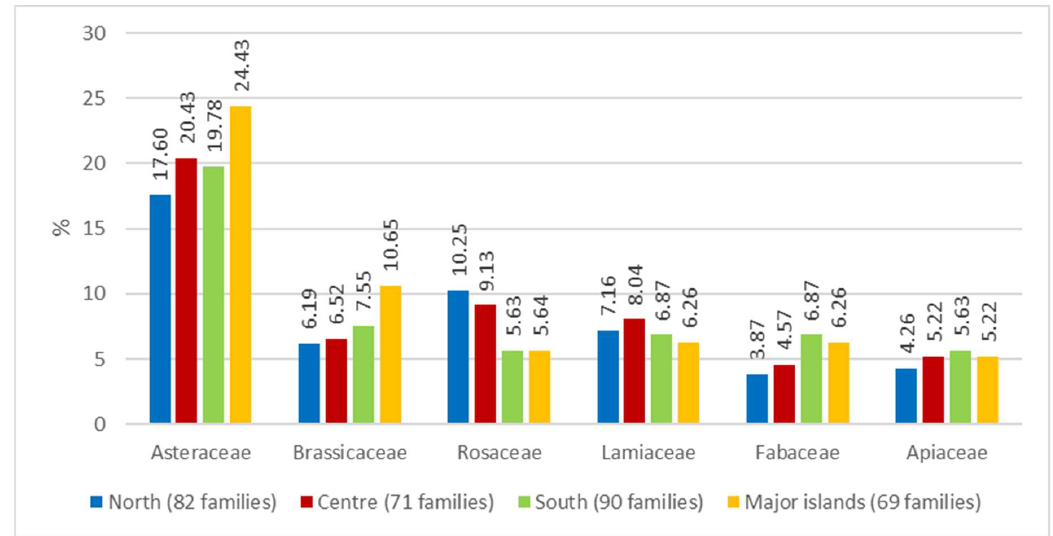
Figure 4. Percentage of the main families of Wild Edible Plants (WEPs) by geographical area.